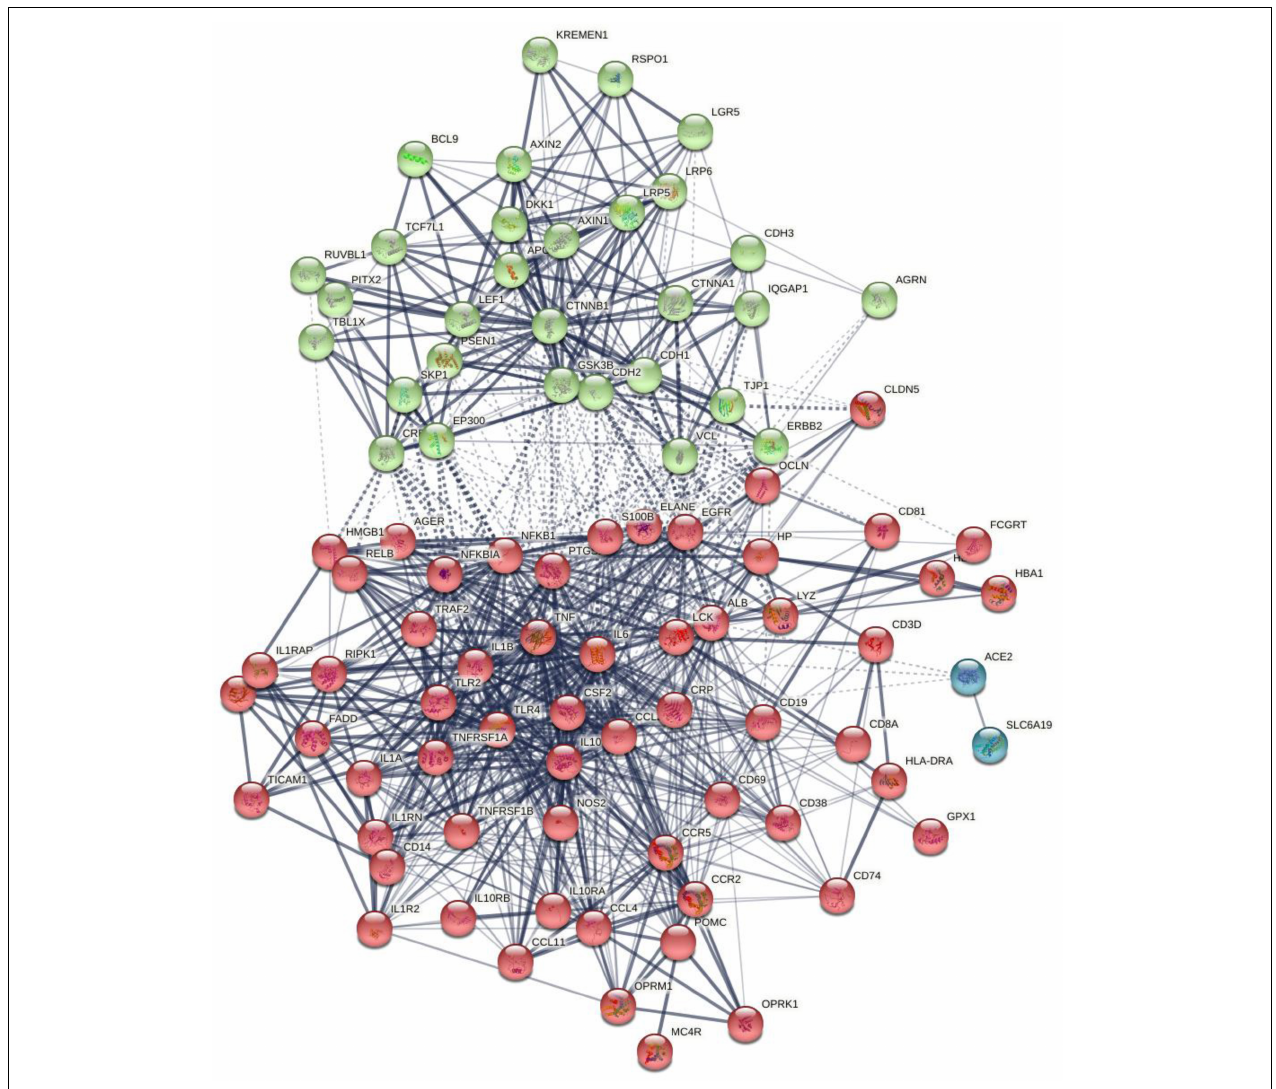
FIGURE 1 | The first-order protein–protein interaction network of chronic fatigue spectrum disorders. Markov Clustering (MCL) cluster analysis found two subnetworks: (1) a first immune subnetwork (red color) was centered around NFKB1, tumor necrosis factor (TNF), interleukin-6 (IL-6), interleukin-10 (IL-10), interleukin-1 (IL-1), TLR4, etc., and (2) a second Wnt/ β -catenin subnetwork (green nodes) centered around CTNNB1. The solid and dotted lines represent connections inside and between clusters, respectively. Different colors represent the various